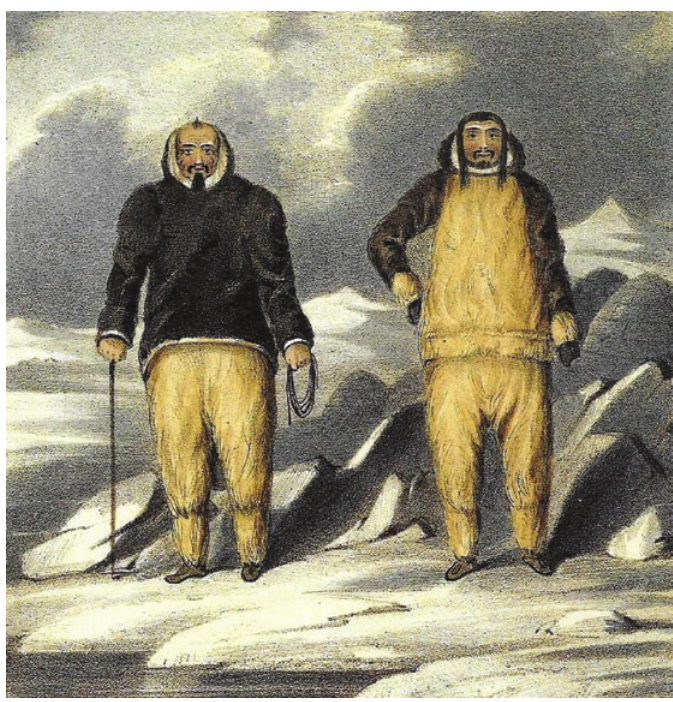
Figure 3. Two Inuit men in deerskin and bearskin. Source : Ross, Second Voyage, Appendix 31, 33, 39 and